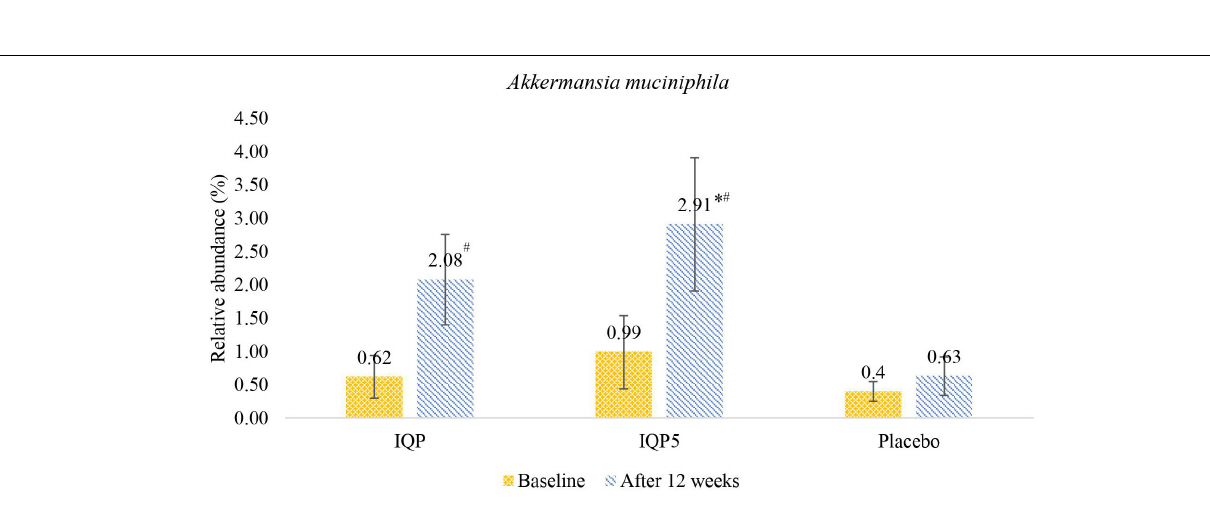
Frontiers in Nutrition |